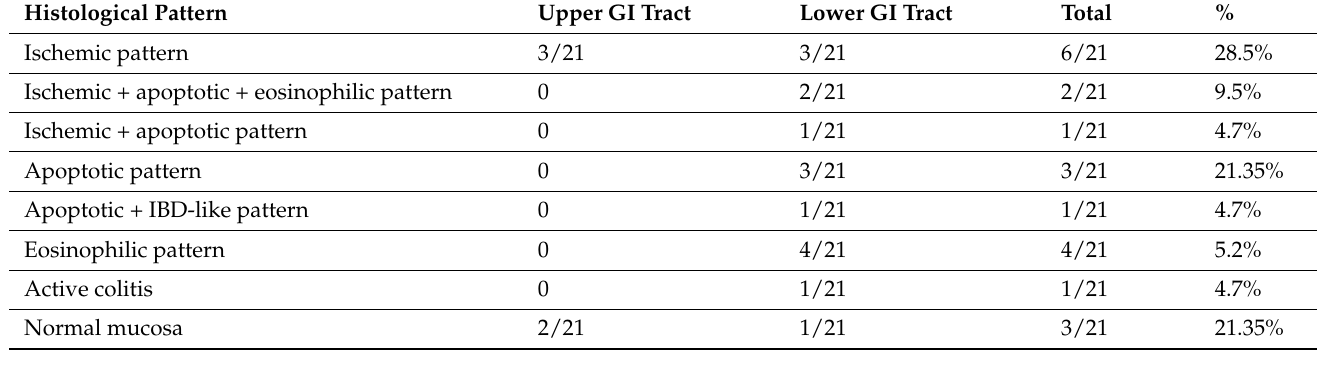
Figure 2. Apoptotic pattern colitis: ( A ) right colon, 9 × , showing glandular atrophy and distortion; ( B ) apoptotic bodies in the glandular element, 25 × (hematoxylin and eosin). Table 3. Histological pattern observed in ICI patients. GI: gastro-intestinal.